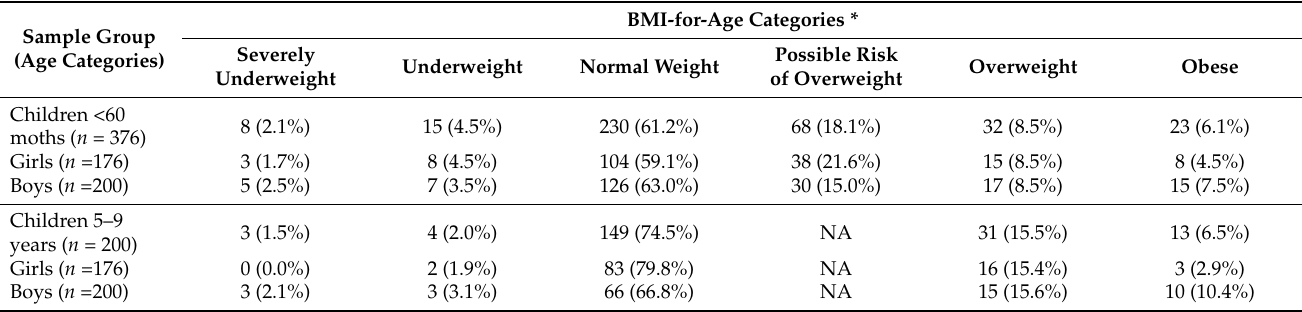
Table 3. Nutritional status overview based on Body mass index (BMI)-for-age categories for